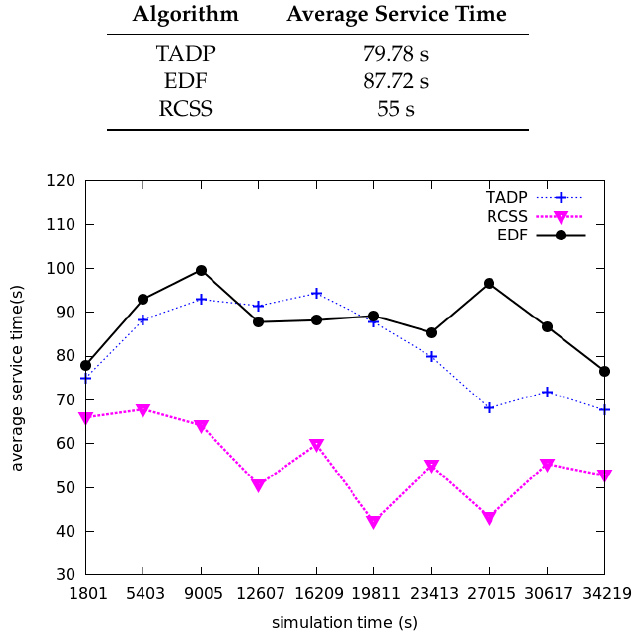
Figure 4. The comparison of average service time among RCSS, TADP and EDF.